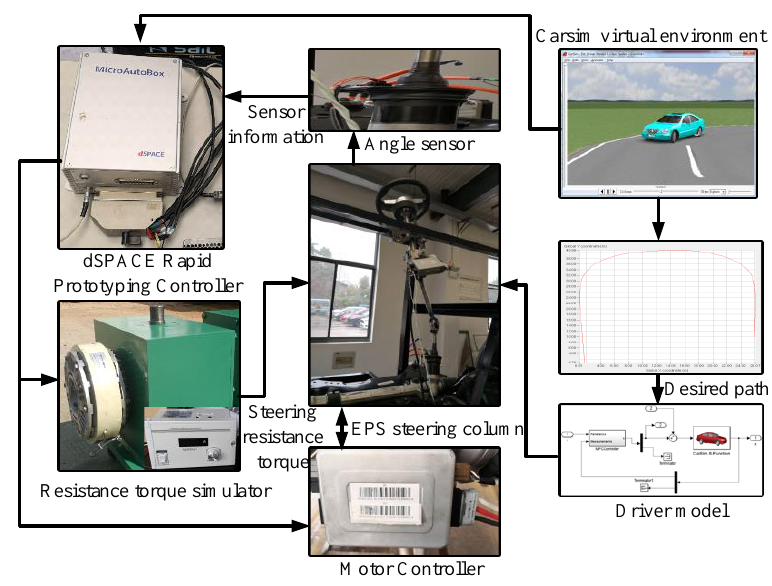
Figure 11. Test bench overall structure.